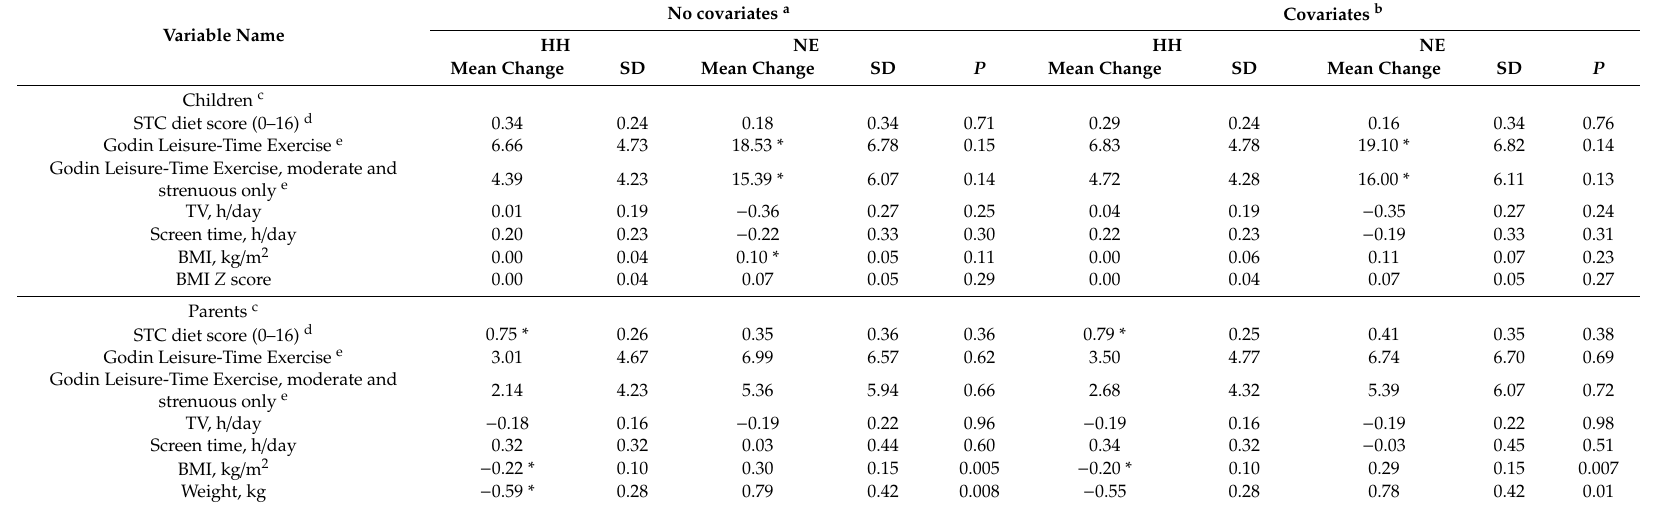
Table 3. Estimated mean change from baseline to postintervention (6–8 weeks): Children and